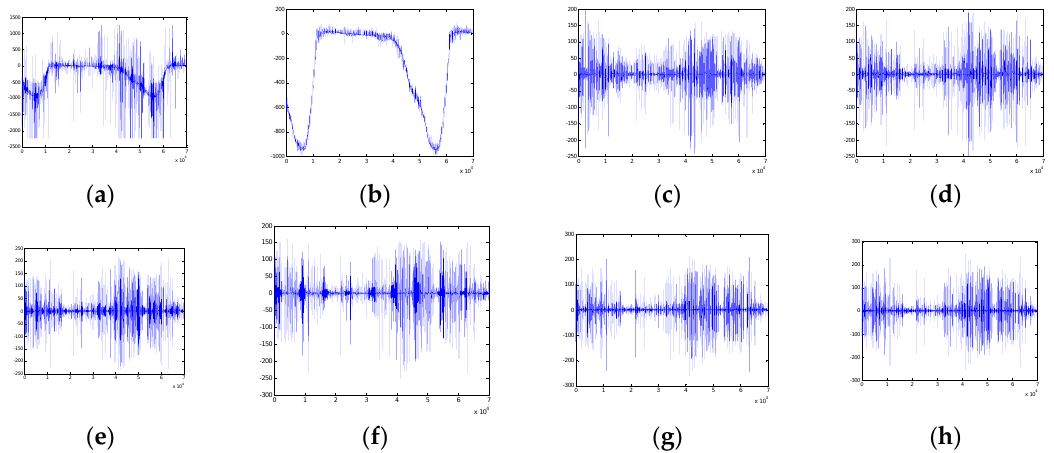
Figure 8. Waveforms of phase-A current and the mode coefficients serials under No. 2 failure state. ( a ) Waveform of phase-A current. ( b – h ) Waveforms of mode coefficients serials from 1st level to 7th level.